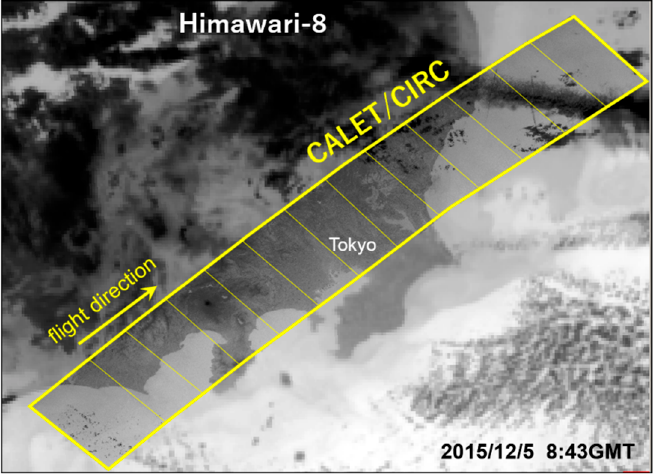
Figure 11. Concatenated CALET / CIRC image overlaid on the geostationary satellite (GS)-based CIRC image acquired by Himawari-8 / AHI around Tokyo on 5 December 2015.